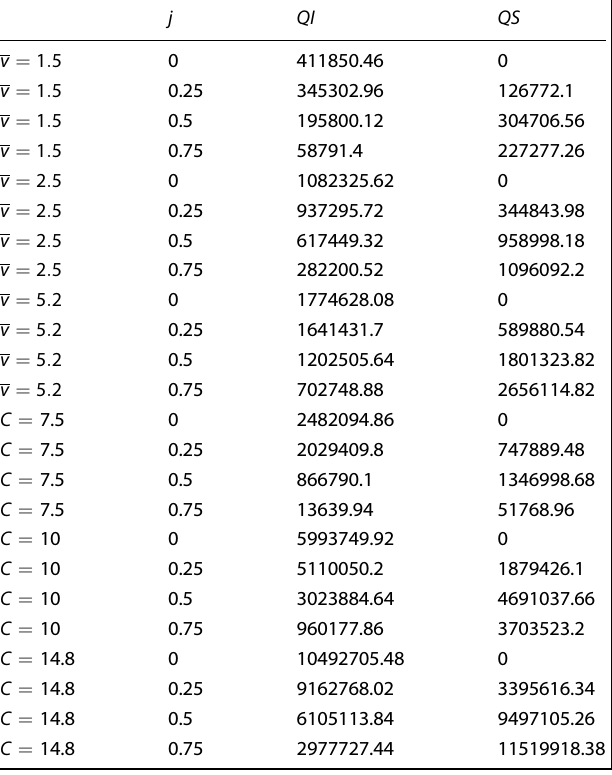
Table 1. Average maximum true positives ( QI ) and false positives ( QS ) in each